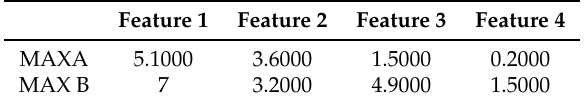
Table 7. The maximum values extracted from the first five features.